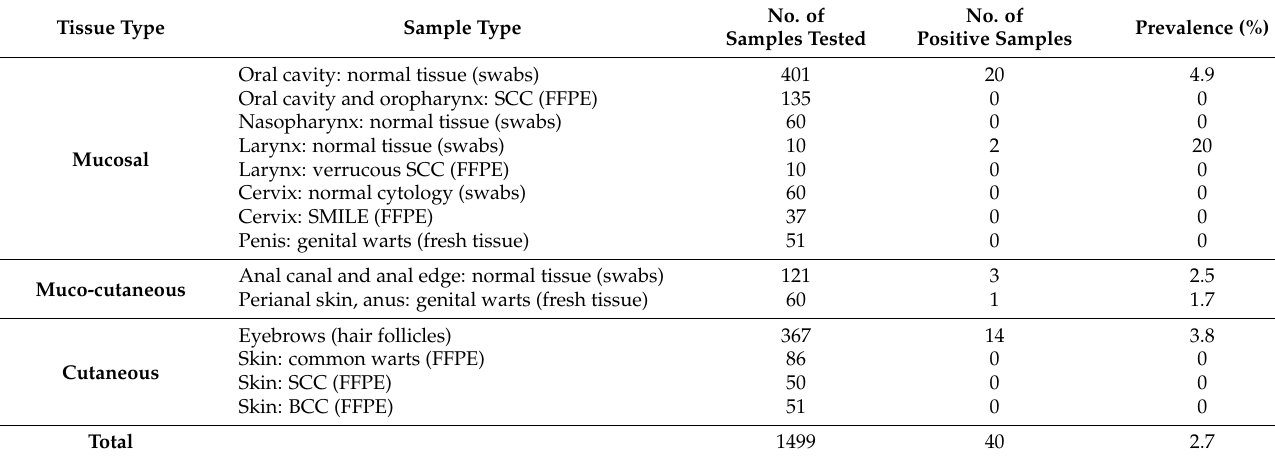
Table 2. Determination of HPV159 infection in a collection of mucosal, muco-cutaneous, and cutaneous clinical specimens. Tissue Type